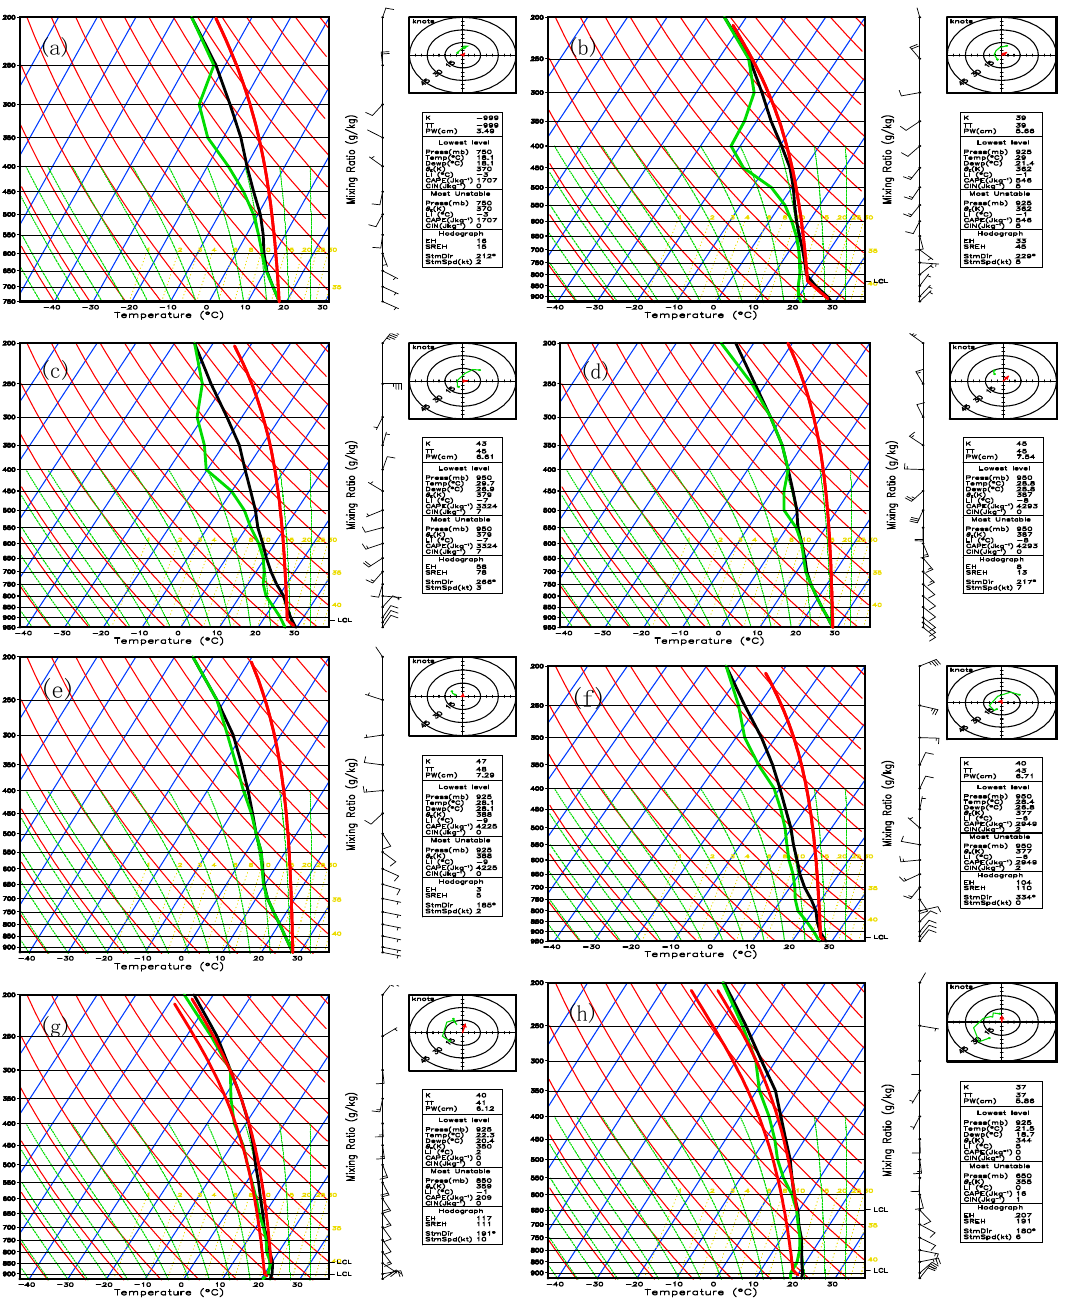
Figure 8. T-Log P chart analysis in the period of MCS generation. In ( a – h ), the thick red line is stratification temperature, the thick black line is environmental temperature, the thick green line is the dew point, the thin blue line is the temperature line, the green dotted line is the wet insulation line, and the red thin line is the dry adiabatic line. ( a ) MCS A T-Log P of (30° N, 102° E) at 1800 UTC 7 July; ( b ) MCS B T-Log P of (30° N, 103° E) at 0600 UTC 8 July; ( c ) MCS C T-Log P of (28° N, 104° E) at 1200 UTC 8 July; ( d ) MCS D T-Log P of (32° N, 104° E) at 1200 UTC 8 July; ( e ) MCS E T-Log P of (31° N, 103° E) at 1800 UTC 8 July; ( f ) MCS F T-Log P of (28° N, 104° E) at 1200 UTC 9 July; ( g ) MCS G T-Log P of (31° N, 104° E) at 1800 UTC 9 July; ( h ) MCS G T-Log P of (31° N, 104° E) at 0000 UTC 10 July.